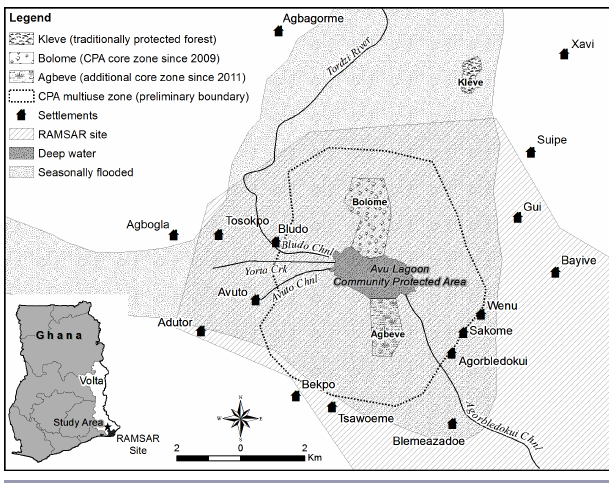
Fig. 1 . Map of Avu Lagoon settlements and the community protected area